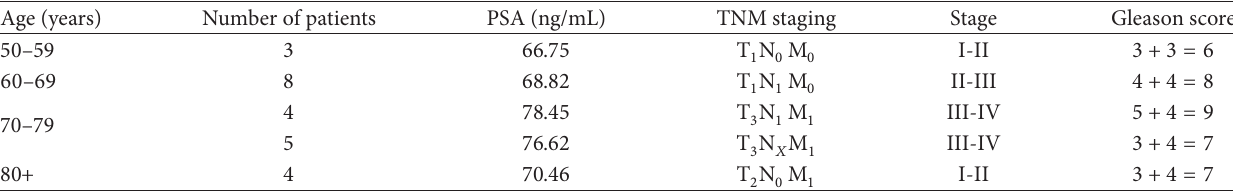
Table 6: The PSA levels and staging of prostate carcinoma